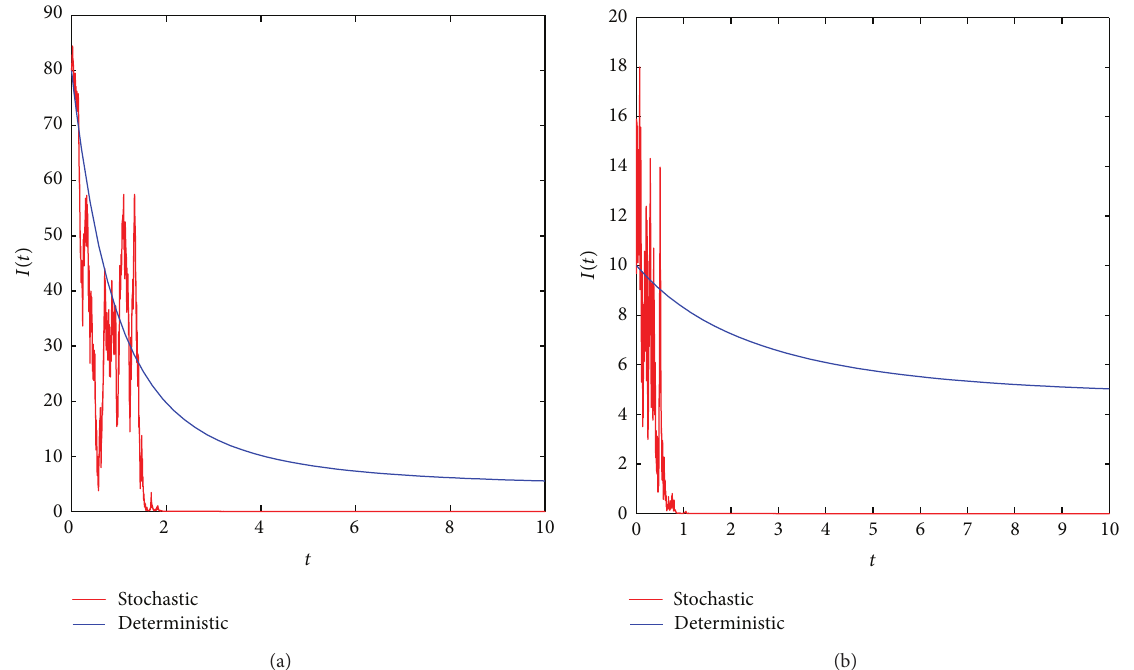
Figure 1: Computer simulations of 𝐼(𝑡) for model (5) and the deterministic model (1), using the EM method with step size 0.001 and with initial values (a) 𝐼(0) = 80 and (b) 𝐼(0) = 10